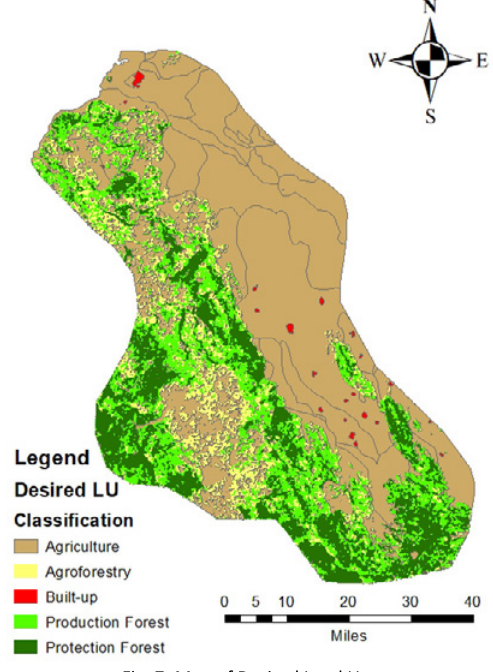
Fig. 7: Map of Desired Land Use